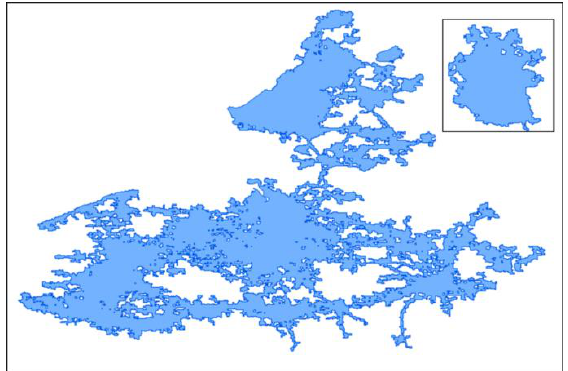
Figure 13. Brussels-Amsterdam vs Mexico City and United States.